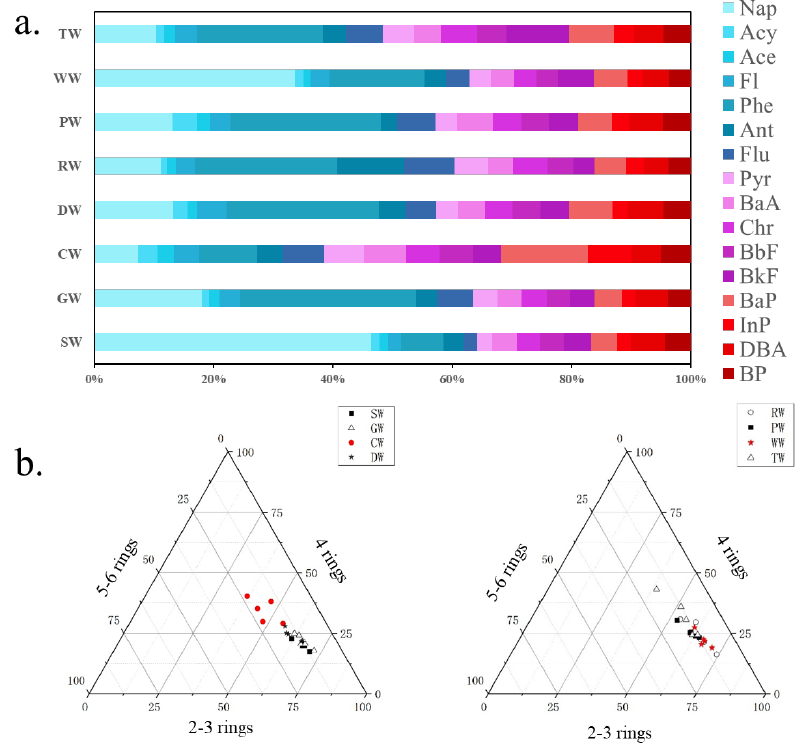
Figure 3. ( a ) The distribution of individual PAHs (the number of rings increases from left to right); ( b ) The relative contributions of PAHs with different numbers of rings. ( b ) The relative contributions of PAHs with different numbers of